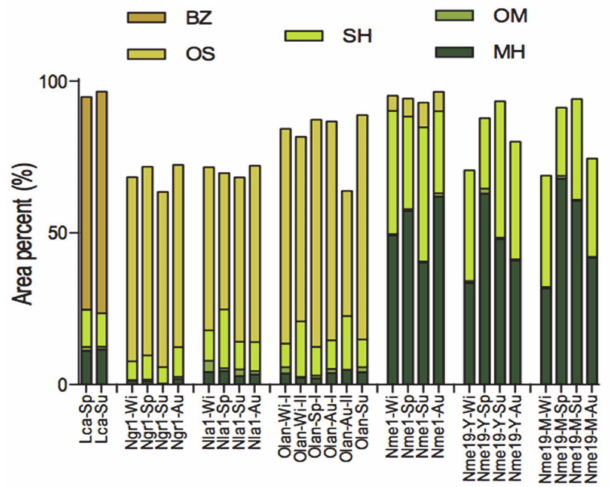
Figure 3. Variations in compounds classes in EO from the leaves of Lauraceae species during seasonal studies. EOs from Amazon: Licaria canella (Lca-Sp, Lca-Su); Cerrado: Nectandra grandiflora (Ngr1-Wi, Ngr1-Sp, Ngr1-Su, Ngr1-Au), N. lanceolata (Nla1-Wi, Nla1-Sp, Nla1-Su, Nla1-Au); Pampa: Ocotea lancifolia (Olan-Wi-I,Olan-Wi-II,Olan-Wi-Sp, Olan-Au-I,Olan-Au-II,Olan-Su); Cerrado: N.megapotamica (Nme1-Wi, Nme1-Sp, Nme1-Su, Nme1-Au); Pampa: N. megapotamica (Nme19-Y-Wi, Nme19-Y-Sp, Nme19-Y-Su, Nme19-Y-Au; Nme19-M-Wi, Nme19-M-Sp, Nme19-M-Su, Nme19-M-Au).